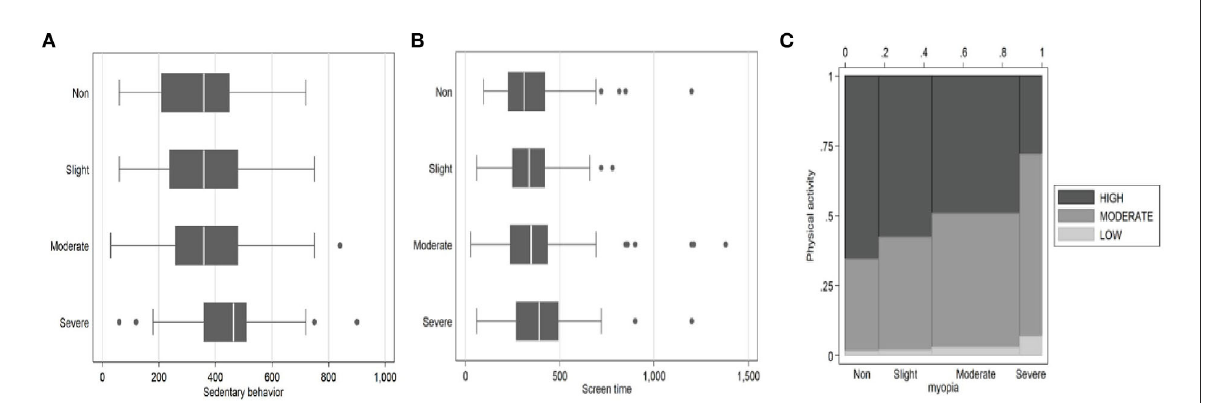
FIGURE2 The relation between screen time, sedentary behavior, physical activity, and myopia. (A) SB and myopia. (B) ST and myopia. (C) PA and